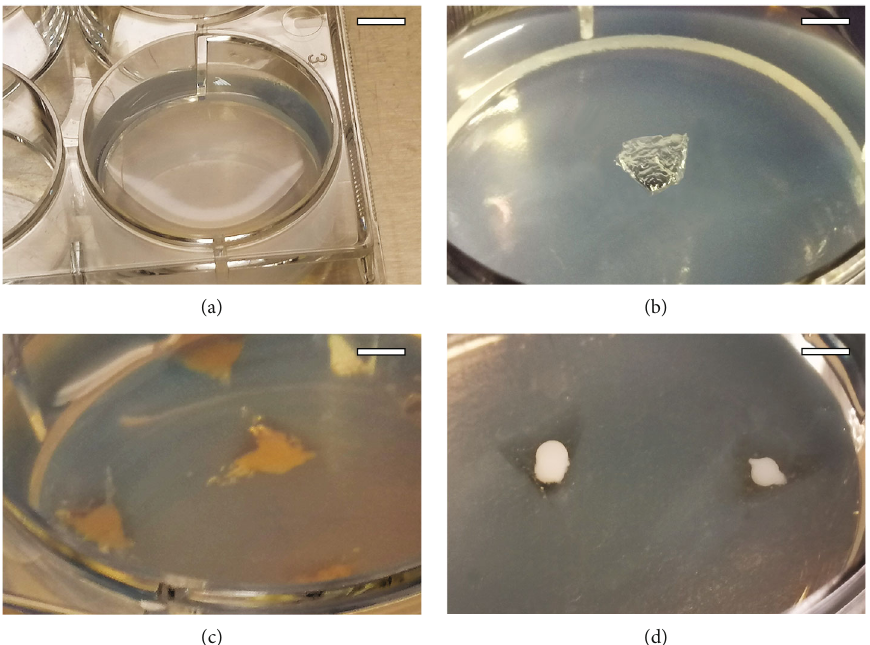
Figure 1: Process of the cell microtissues elaboration in 3% agarose wells. (a) 3% agarose hydrogel after 48h at 4 ° C; (b) elaboration of wells in agarose hydrogel; (c) cellular seeding in agarose wells; and (d) completely formed microtissues after 72h of cell culture. Scale bars — A: 12mm; B-D: